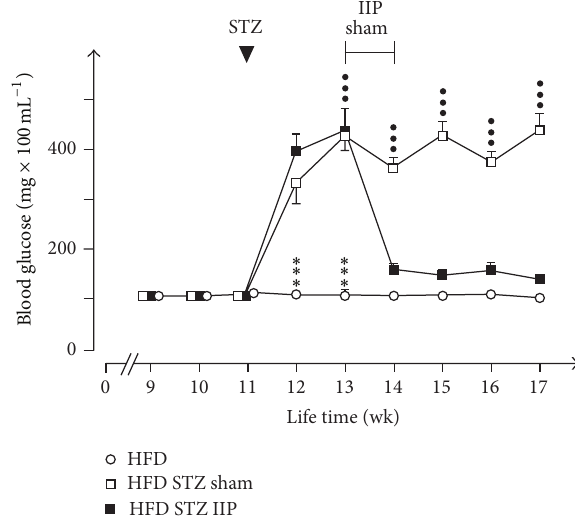
Figure 3: Effects of HFD, STZ treatment, and IIP surgery on blood glucose levels in nonfasting rats. Blood glucose was measured between 9 and 10 a.m. in rats that had free access to HFD and water. Mean values ± SEM of 9 animals are indicated. eee 𝑝 < 0.001 difference between HFD and HFD STZ sham animals and ∗∗∗ 𝑝 < 0.001 difference between HFD and HFD STZ IIP